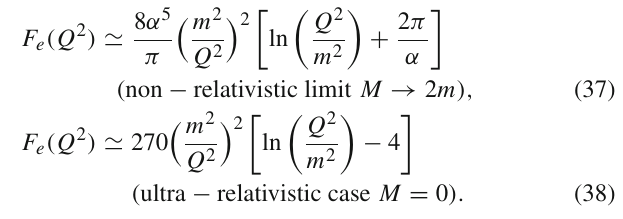
Fig. 11 Elastic form factors of n = 1 states of Table 1 (solid lines): No. 1 (normal) on top and No. 3 (abnormal) at bottom; the dashed line corresponds to the state with κ = 0 with the same binding energy (and rms radius) as the state No. 3 with κ =